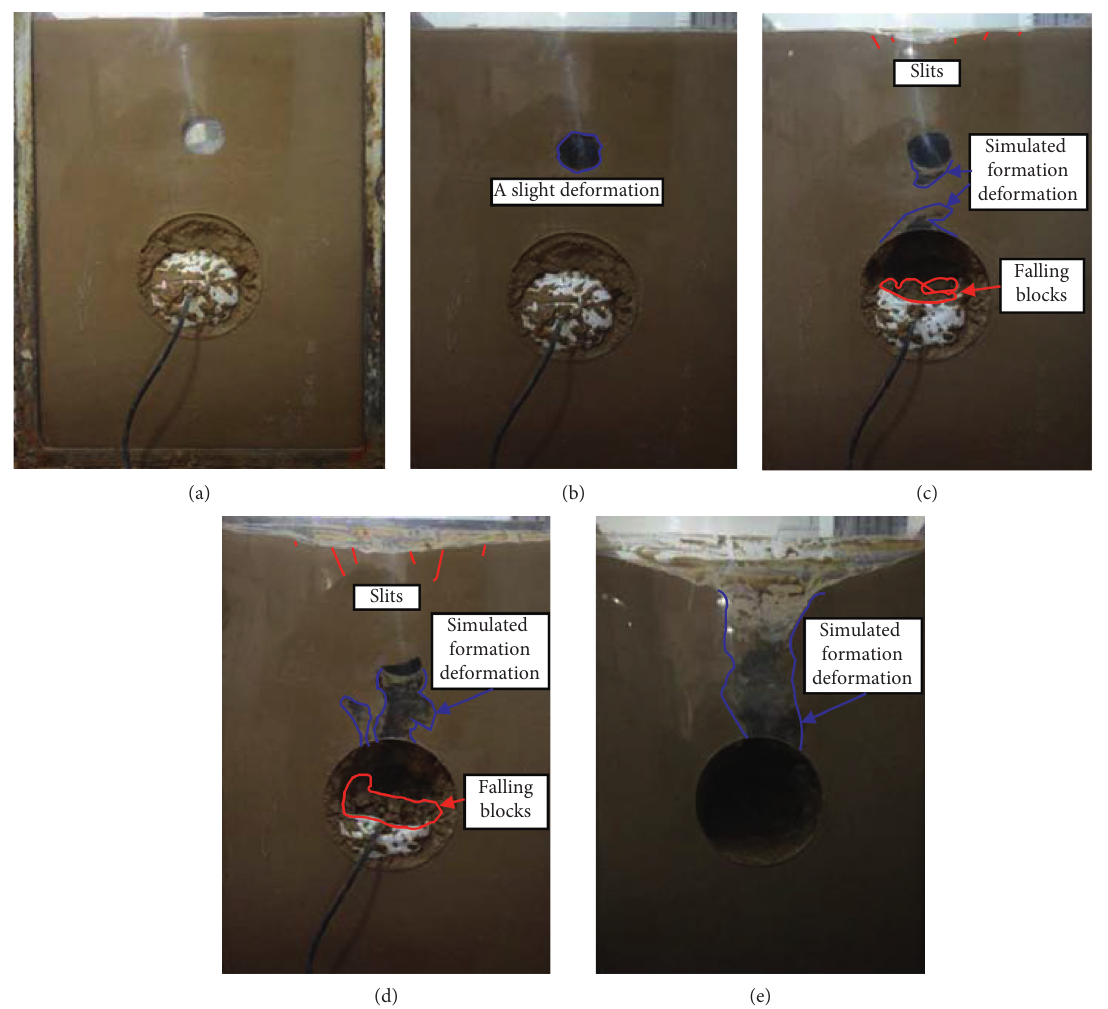
Figure 11: Instability evolution process of stratum with cavity. (a) P � 0MPa. (b) P � 0.02MPa. (c) P � 0.04MPa. (d) P � 0.06MPa. (e) P �